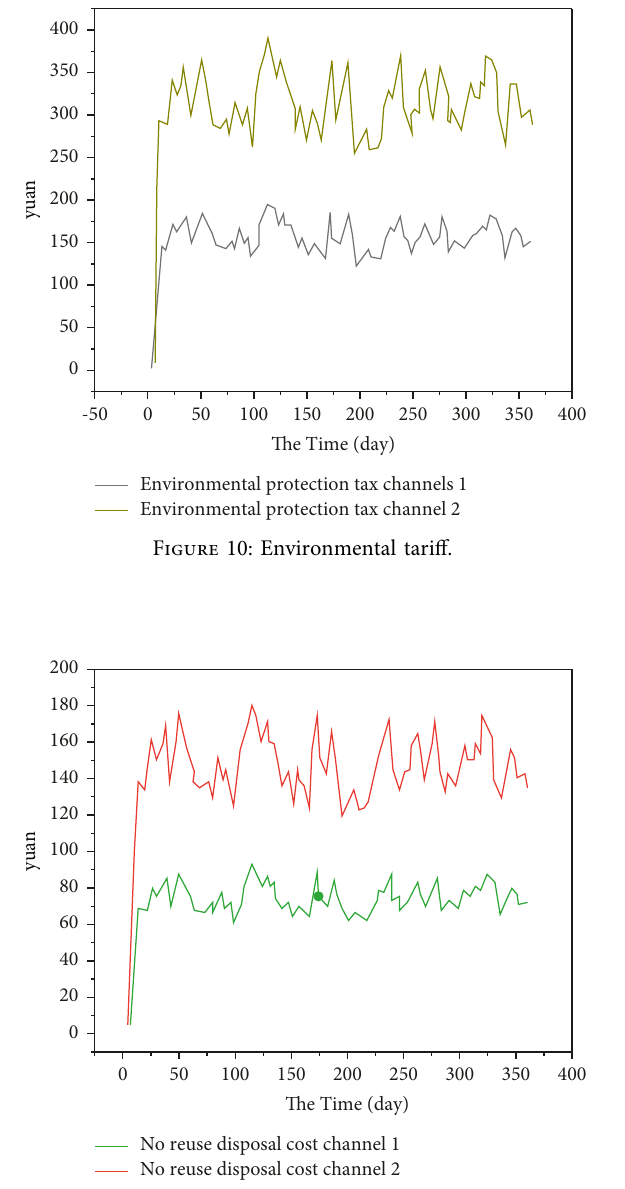
Figure 11: Waste disposal costs cannot be reused.